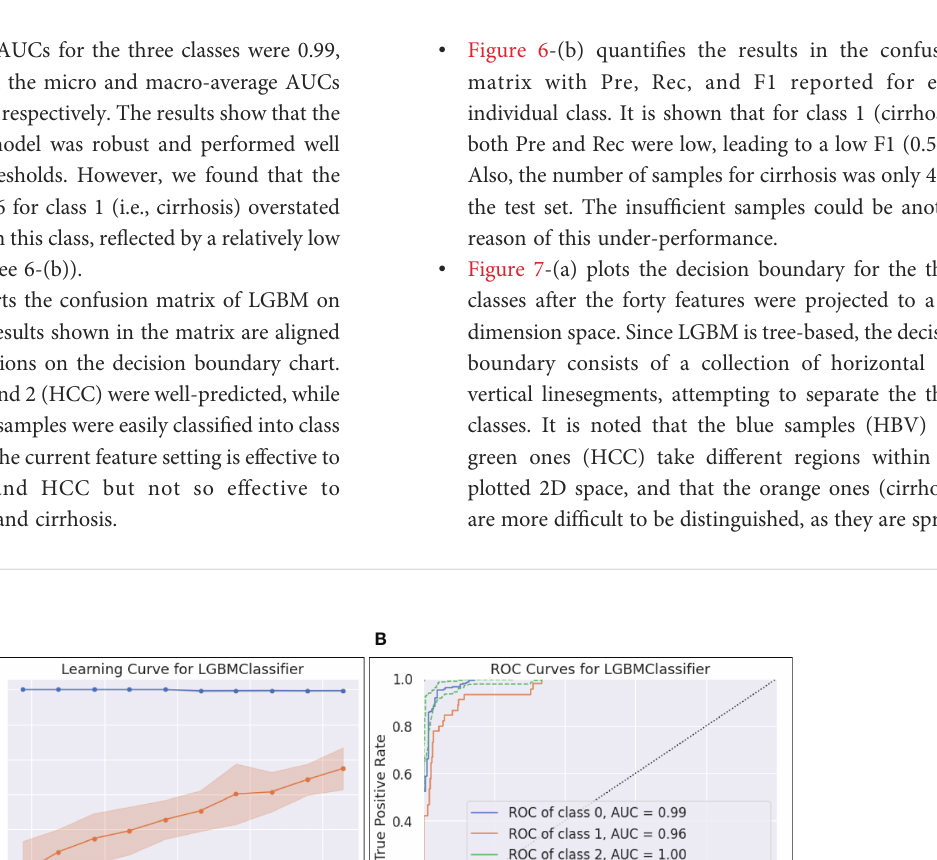
FIGURE 5 (A) Learning curve for LGBM; (B) ROC curves for